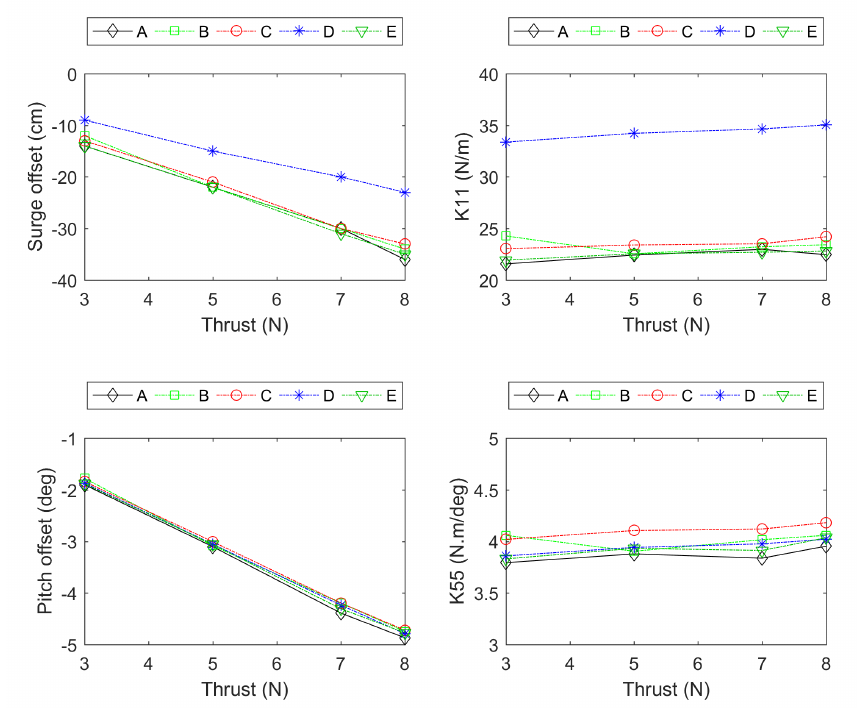
Figure 5. Surge and pitch offset ( left ), and surge ( K 11 ) and pitch ( K 55 ) stiffness coefficients ( right ). Four out of five data sets give similar total surge stiffness. The surge stiffness for facility D is significantly bigger due to springs used in the mooring system. The surge stiffness coefficients of the 4 other campaigns are comparable, although not identical,